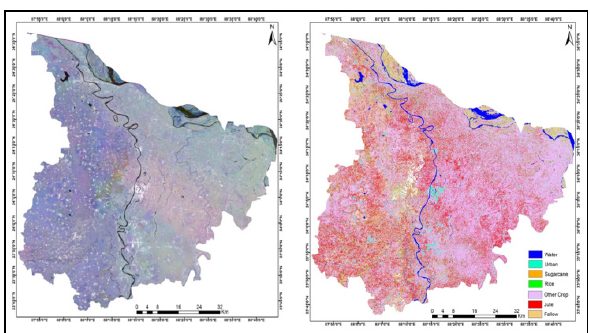
Figure 6. Classification methodology for Jute using multi spectral data